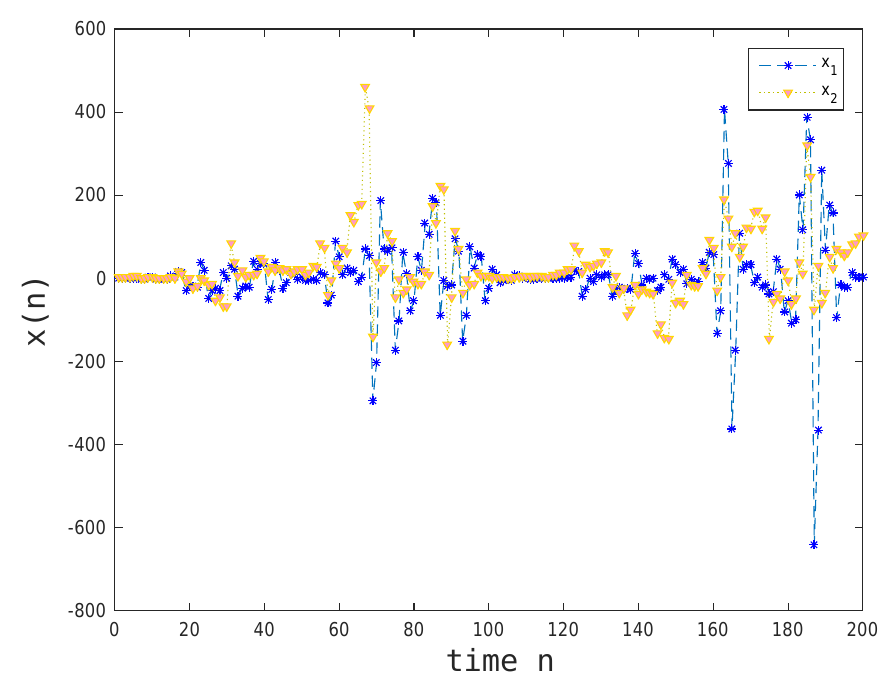
Figure 2. State trajectories of system (40) without